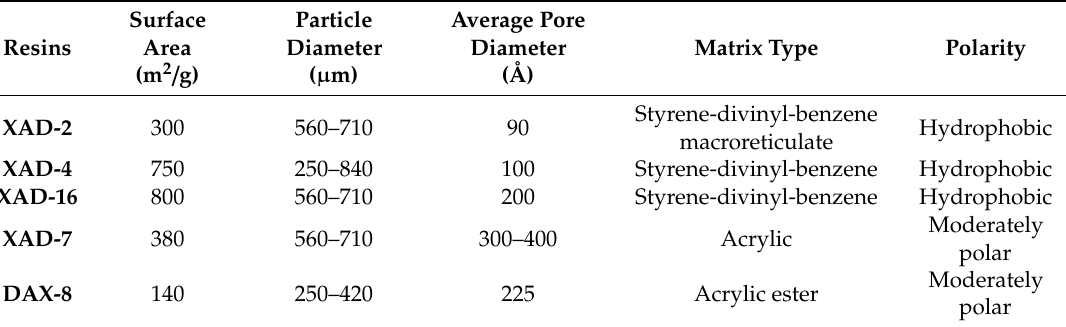
Table 2. Characteristics of the MPR used in the present